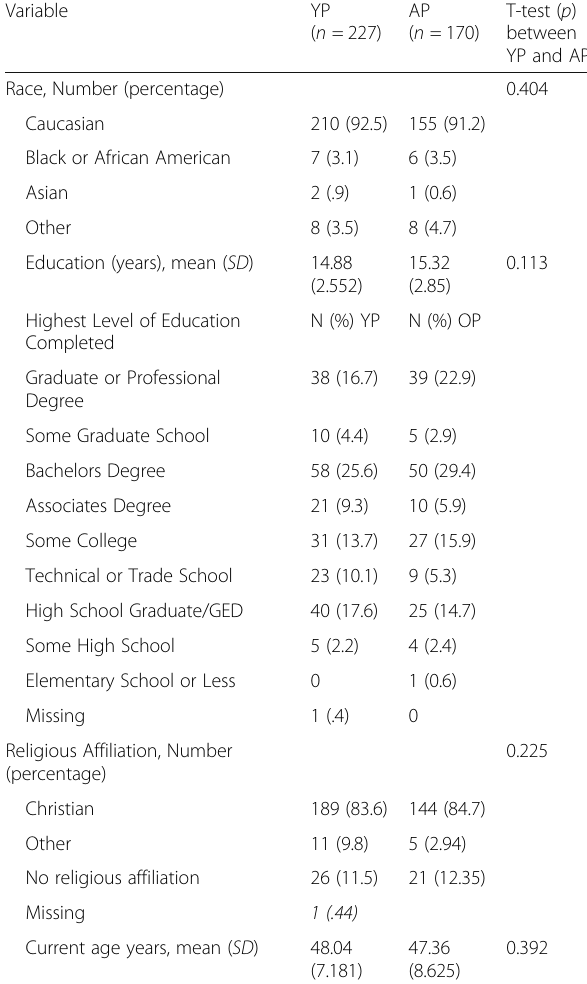
Table 1 Demographic information for partners of young breast cancer survivors and partners of healthy acquaintance controls